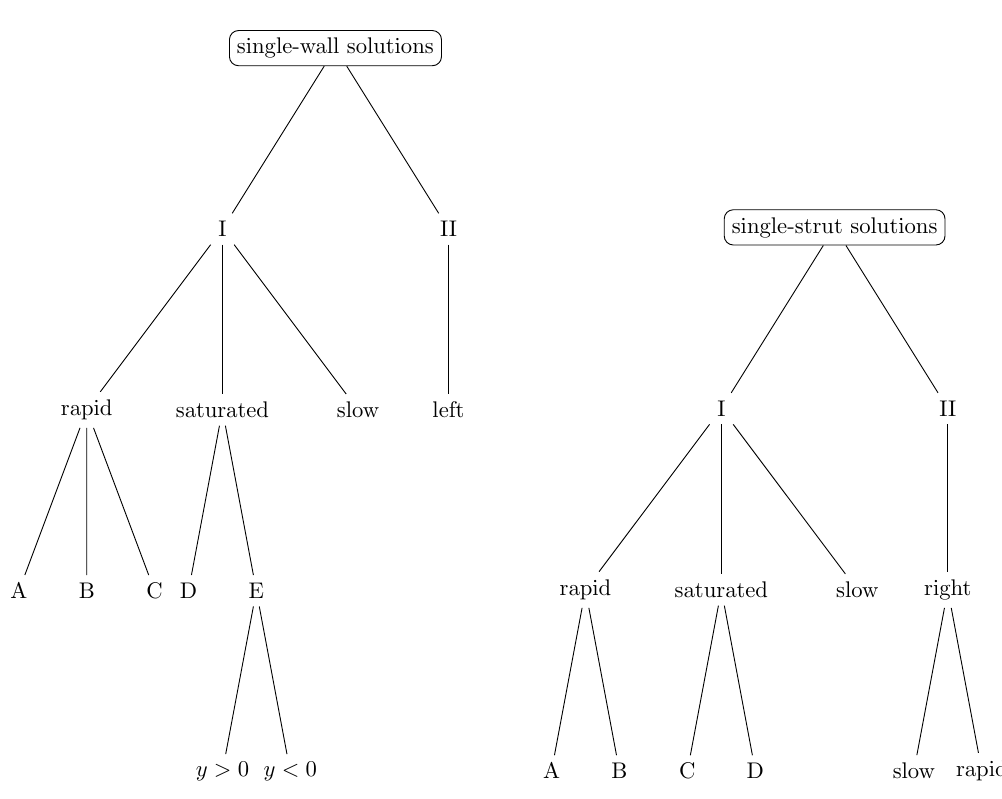
Figure 1 . Classification of distinct single-wall and single-strut solutions with t timelike. Each leaf node represents a qualitatively-distinct solution.